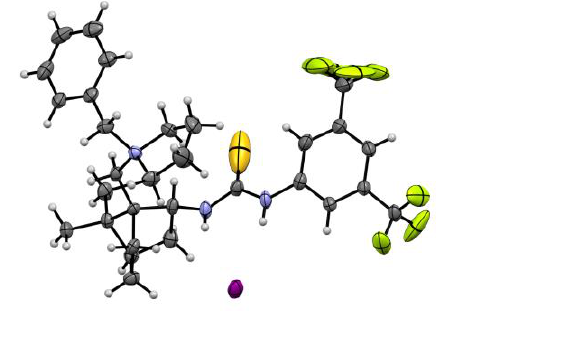
Figure 2. Molecular structures of products III ( a ) and VI-Br ( b ). Thermal ellipsoids are shown at 50% probability.